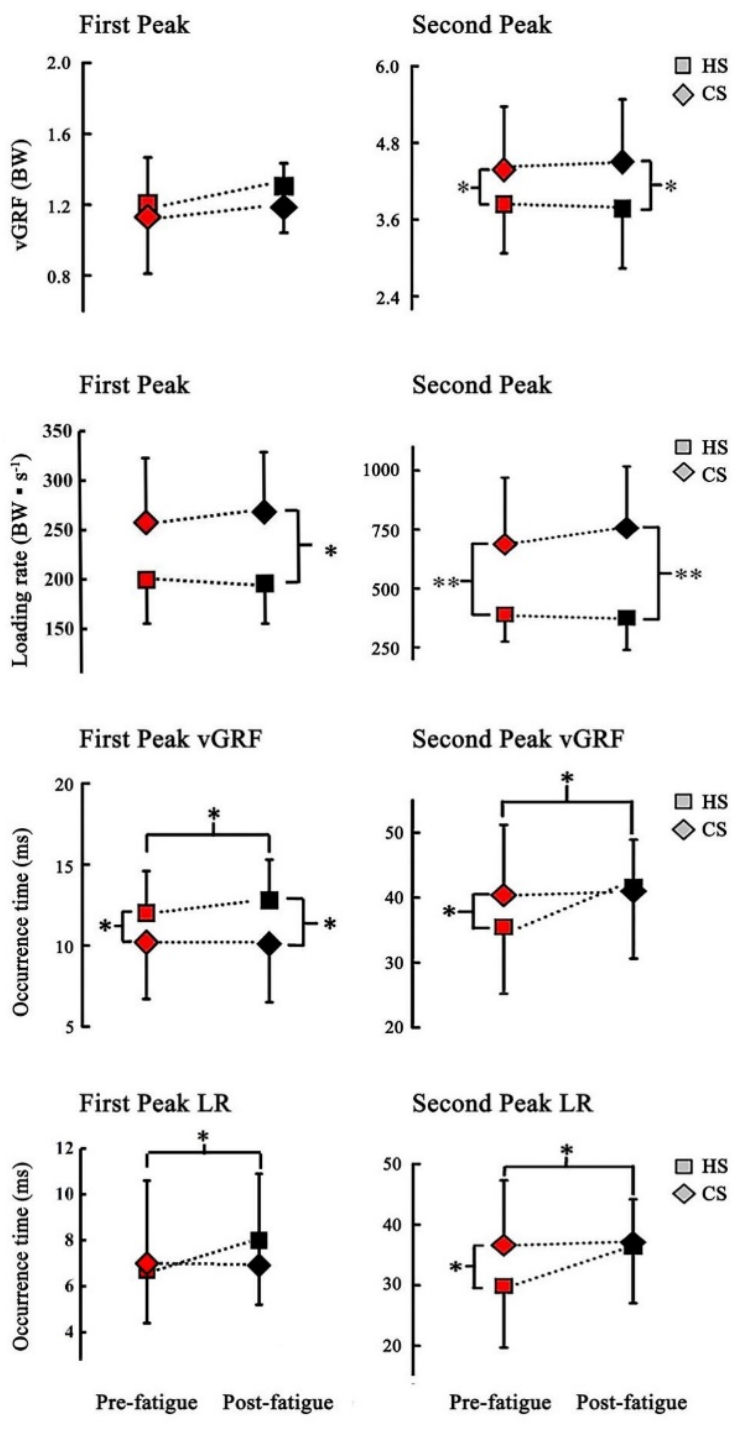
Figure 5. Comparison of vGRF, LR and occurrence time (t Fz1 , t Fz2 , t G1 , t G2 ) between HS and less cushioned shoes (CS) in pre-fatigue and post-fatigue conditions. * indicates significant difference ( p < 0.05). ** indicates a significant difference ( p < 0.01). Right- pointing and left-pointing brackets indicate a significant difference between shoes in pre-fatigue and post-fatigue conditions ( p < 0.05). Upper-pointing brackets indicate a significant difference between pre-fatigue and post-fatigue conditions for HS ( p <